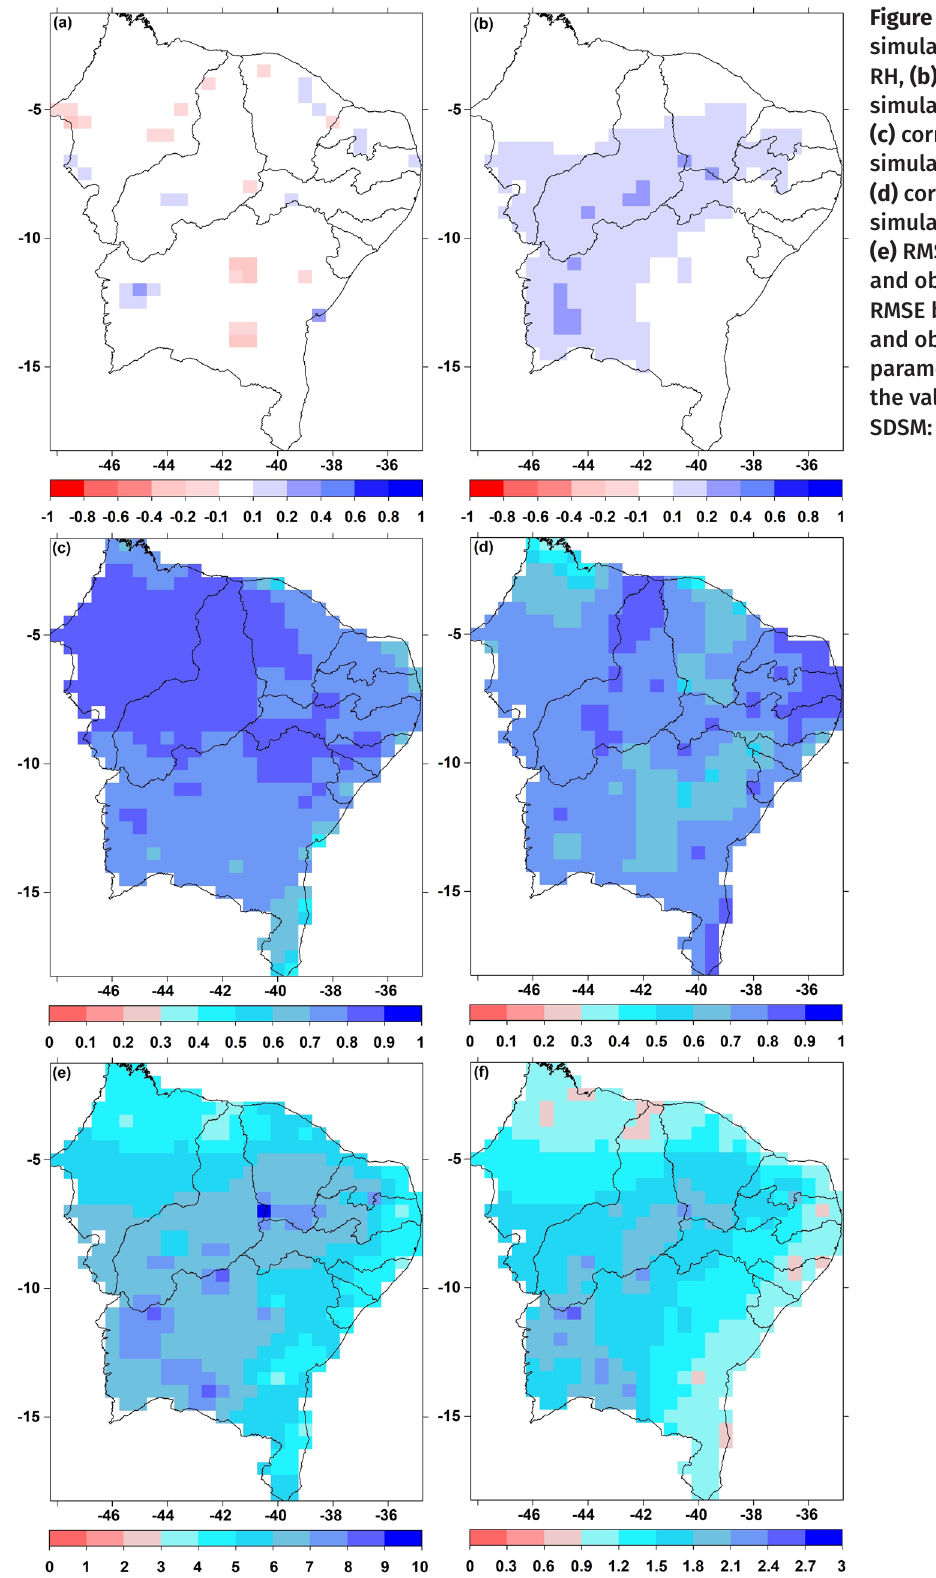
Figure 4. (a) Bias between simulated and observed RH, (b) Bias between simulated and observed Td, (c) correlation r between simulated and observed RH, (d) correlation r between simulated and observed Td, (e) RMSE between simulated and observed RH, and (f) RMSE between simulated and observed Td. Statistical parameters obtained for the validation period of the SDSM: